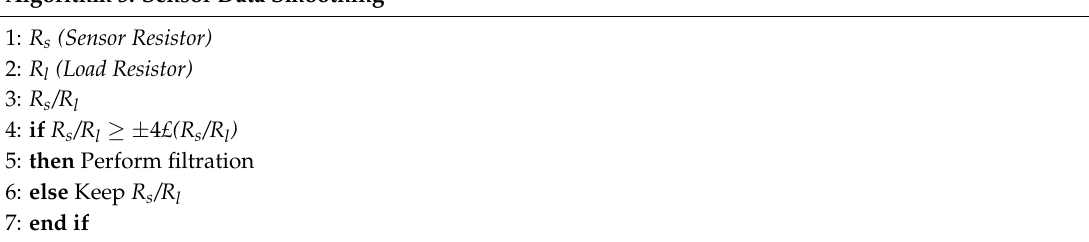
Algorithm 3: Sensor Data Smoothing